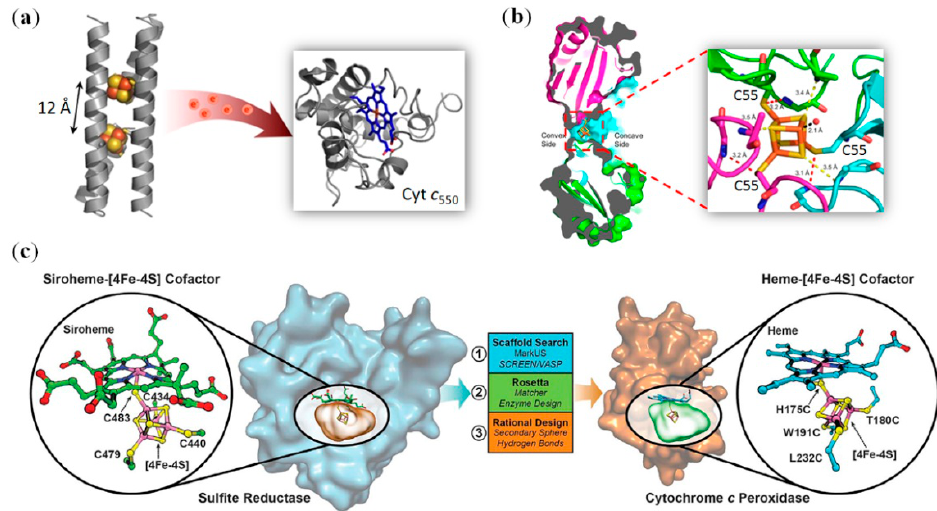
Figure 6. ( a ) Rational design of two [4Fe-4S] clusters in domain-swapped dimer(DSD)-Fdm that transfer electrons to ferric Cyt c . Reprinted with permission from [86]. Copyright 2014 American Chemical Society; ( b )X-ray structure of BMC-T1-S55C and a close-up view of the [4Fe-4S] cluster (PDB code 5DII). Reprinted with permission from [89]. Copyright 2014 American Chemical Society; ( c ) Rational design of a [4Fe-4S] cluster in cytochrome c peroxidase (C c P) that closely mimics the active site of native sulfite reductase (SiR). Reprinted with permission from [98]. Copyright 2018 AAAS.